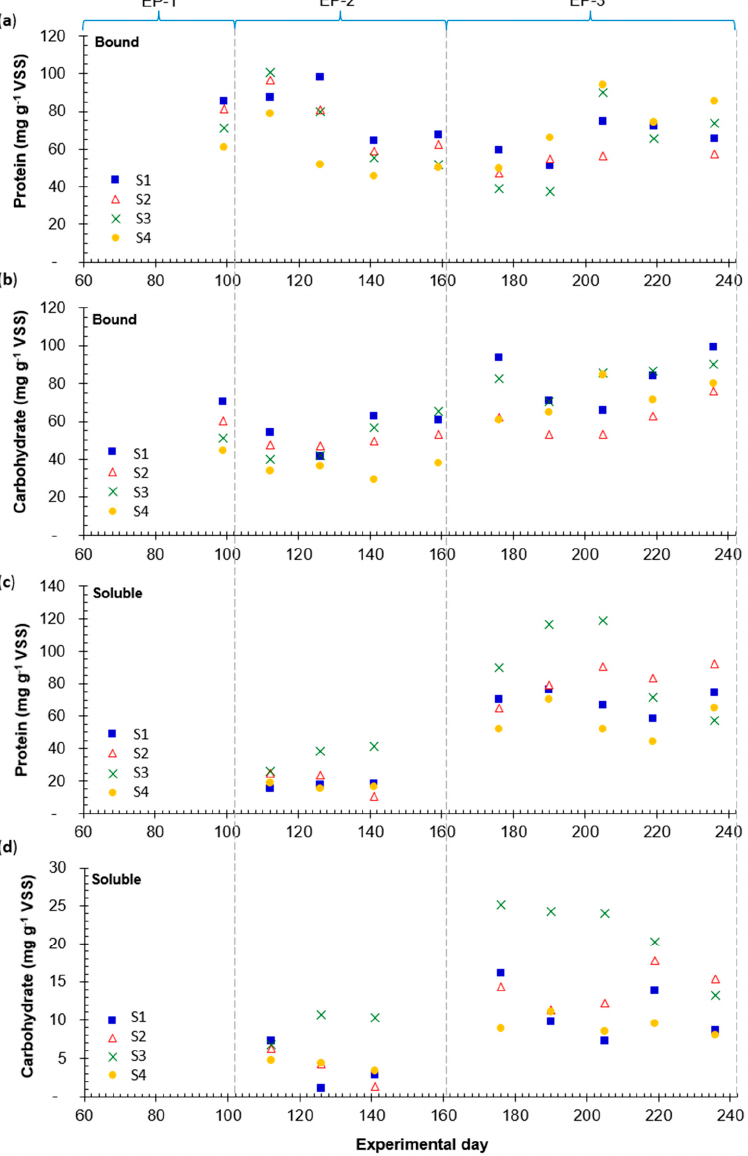
Figure 6. EPS composition during experimental period: ( a ) bound protein, ( b ) bound carbohydrate; ( c ) soluble protein, ( d ) soluble carbohydrate. Vertical dotted lines indicate start of experimental phases. Values for control parameters (SRT and TMP) in each phase are shown in Figure 2 and Table A2.